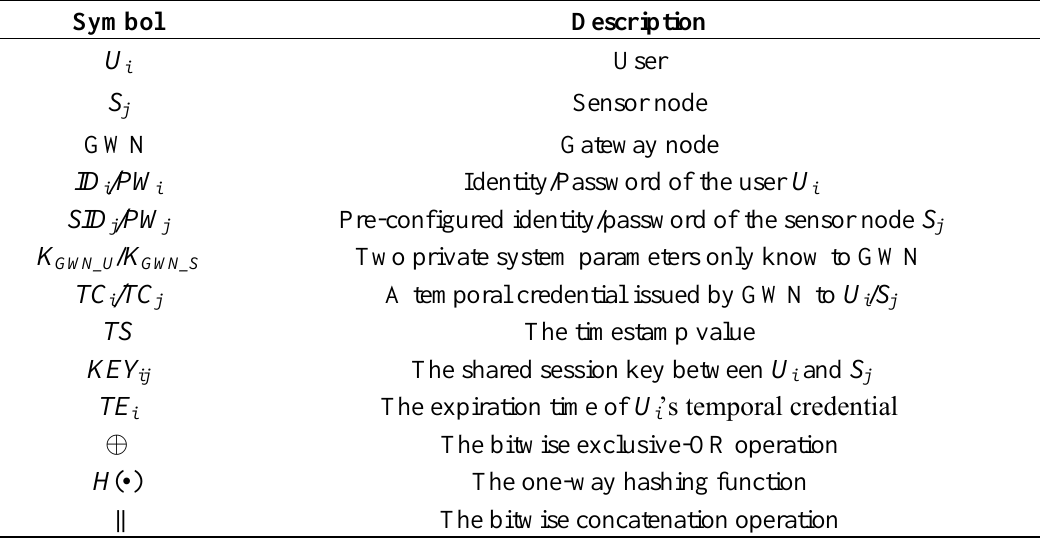
Table 1. Notations used throughout this